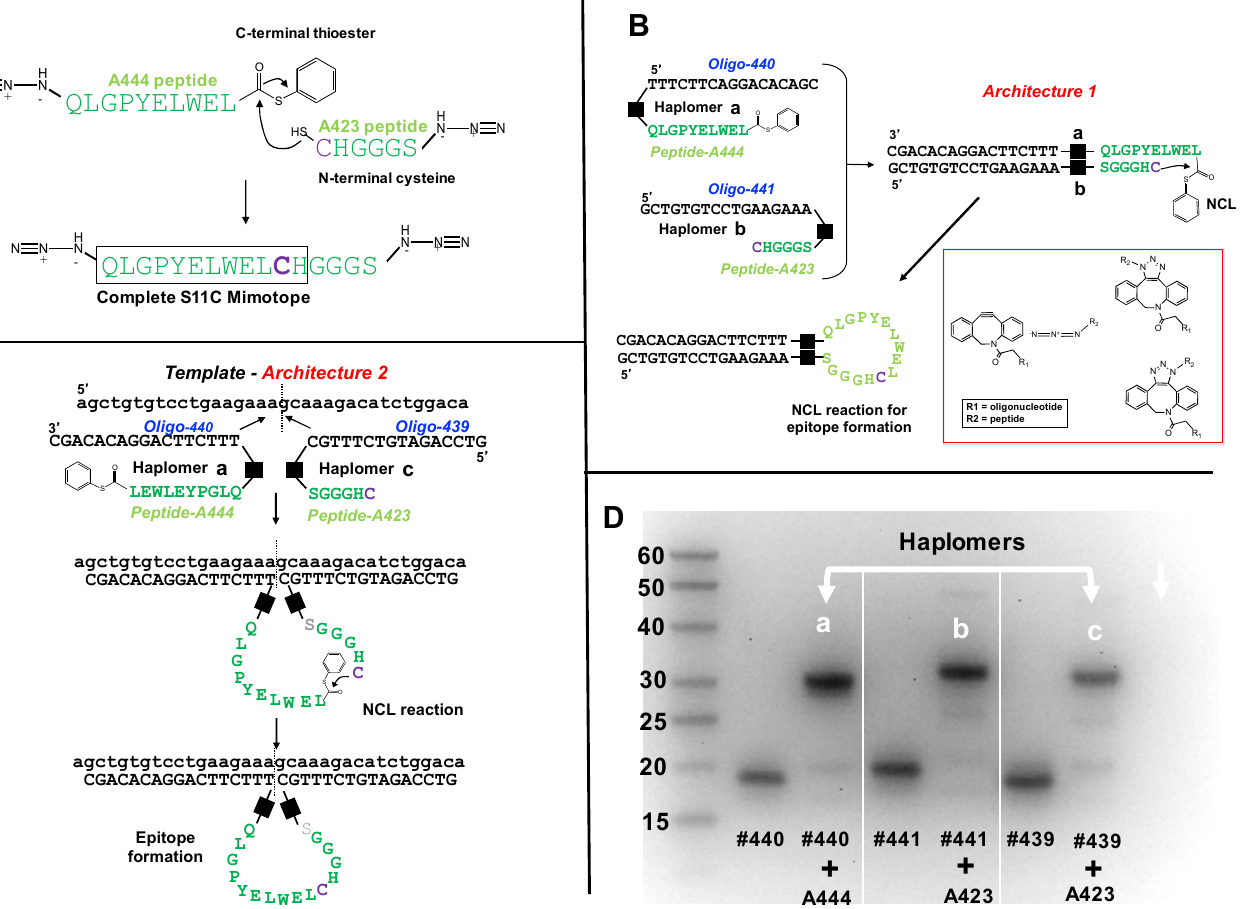
Figure 1. Trastuzumab haplomer structures and analyses. ( A ) Structures of the trastuzumab S11C mimotope split into two NCL-activated peptide segments N-terminal to the cysteine residue, where the larger A444 peptide bears a C-terminal phenyl thioester, and the C-terminal peptide has N-terminal cysteine. Joining the two peptides by NCL recapitulates the original S11C peptide. ( B ) Schematic depiction of Architecture 1 with mutual hybridization of haplomers [a] and [b] for assembly of trastuzumab mimotope S11C, and their mutual hybridization in Architecture 1. Black squares in Figure 1B and C denote the triazole linkage resulting from the azide-DBCO reactions, shown structurally in the red subpanel box. ( C ) Schematic depiction of Architecture 2, with haplomers [a] and [c] , and their hybridization on adjacent template sites for assembly of trastuzumab mimotope S11C. ( D ) Formation of haplomers [a] – [c] as shown with a 15% denaturing urea gel, with molecular weight markers (bases) indicated. Haplomer [a] was formed when N-terminally azide-modified peptide A444 (Figure 1A) was reacted in a 20-fold molar excess in sodium phosphate/100 mM NaCl buffer pH 7.0 with 5 ′ - dibenzocyclooctyne (DBCO)-modified oligonucleotide #440 (DBCO-TTTCTTCAGGACACAGC) for 16 h. Haplomers [b] and [c] were respectively formed when C-terminally modified peptide A423 (Figure 1A) was incubated under similar conditions with 3 ′ - DBCO-modified oligonucleotide #441 (GCTGTGTCCTGAAGAAA-DBCO) or 3 ′ -